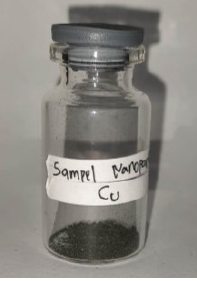
3 sharp peaks in the diffractogram.